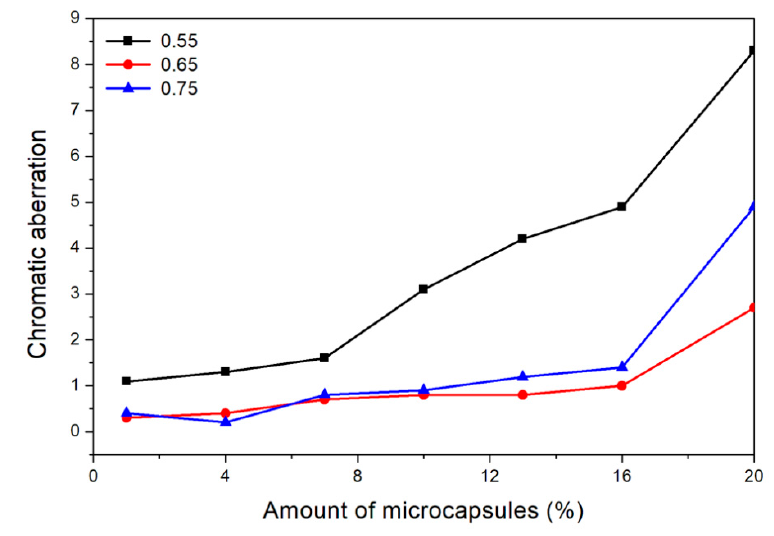
Figure 1. Effect of microcapsules on chromatic aberration of paint film.